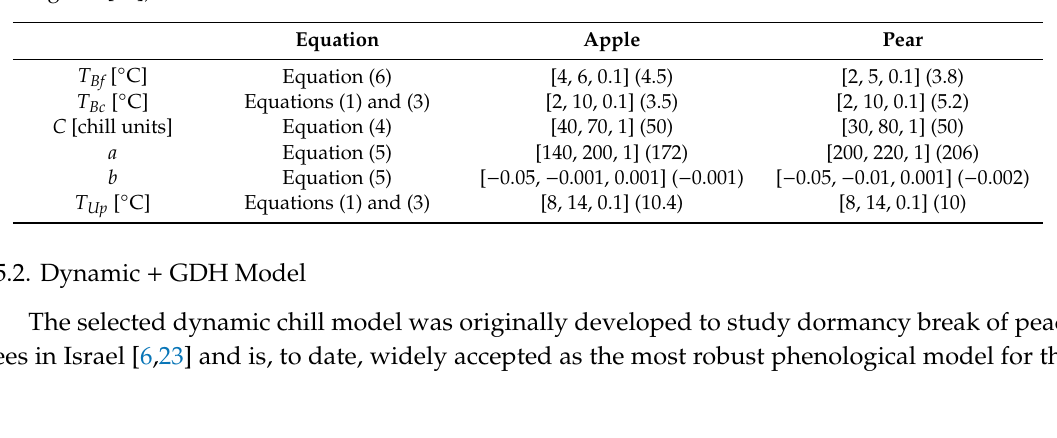
Table 1. Parameter space—in squared brackets: Lower and upper bound and step; in round brackets: Initial guess (best fit parameters and boundaries based on parametrizations for German fruit growing regions